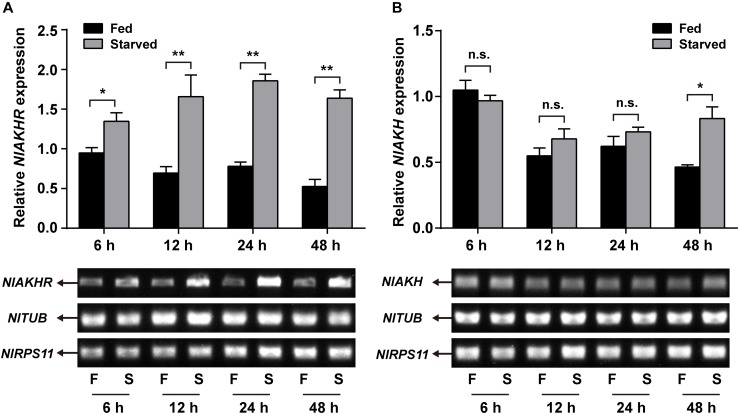
Effects of starvation on the expression of NlAKHR
(A) and NlAKH
(B). Newly emerged females (within 24 h) were fed (F) or starved (S) for different hours. Differences between mRNA levels were determined by qRT-PCR and RT-PCR. TUB and RPS11 were used as internal reference controls. Results are displayed as means ± SE of three independent replicates and asterisks indicate significant differences between the fed and starved groups at the same time point (∗P < 0.05 and ∗∗P < 0.01) by Student’s t-test. n.s. represents no significant difference (P > 0.05).